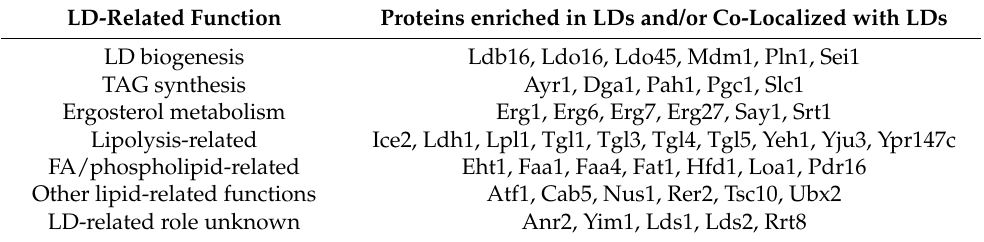
Table 1. Yeast LD-associated proteins validated in [36] and other studies. LD-Related Function Proteins enriched in LDs and/or Co-Localized with LDs LD biogenesis Ldb16, Ldo16, Ldo45, Mdm1, Pln1, Sei1 TAG synthesis Ayr1, Dga1, Pah1, Pgc1, Slc1 Ergosterol metabolism Erg1, Erg6, Erg7, Erg27, Say1, Srt1 Lipolysis-related Ice2, Ldh1, Lpl1, Tgl1, Tgl3, Tgl4, Tgl5, Yeh1, Yju3, Ypr147c FA/phospholipid-related Eht1, Faa1, Faa4, Fat1, Hfd1, Loa1, Pdr16 Other lipid-related functions Atf1, Cab5, Nus1, Rer2, Tsc10, Ubx2 LD-related role unknown Anr2, Yim1, Lds1, Lds2,